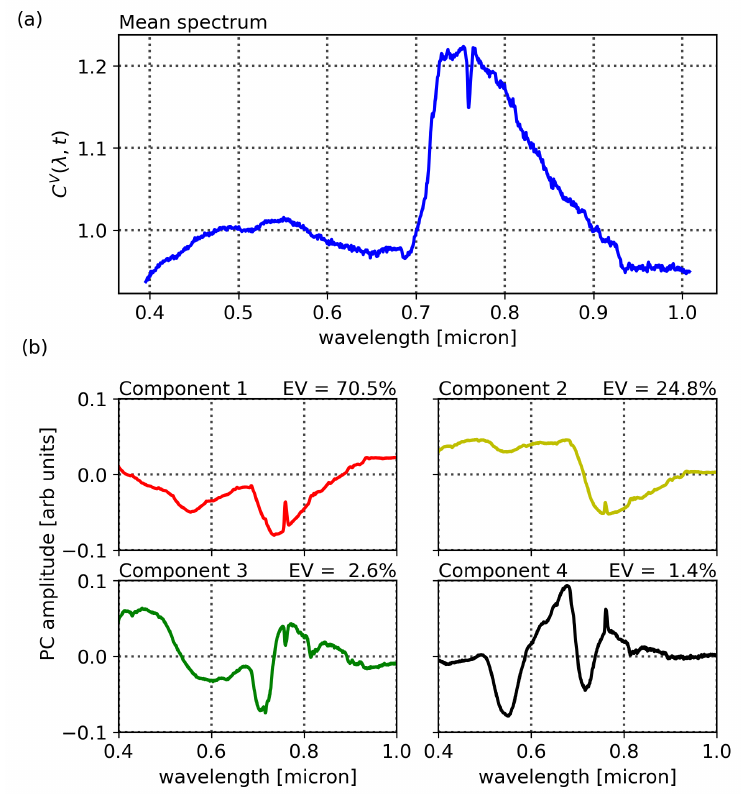
Figure 8. ( a ) The mean Compound Ratio spectrum of vegetation pixels. ( b ) The amplitude of each of the 4 principal components as functions of wavelength and their Explained Variance (EV) in